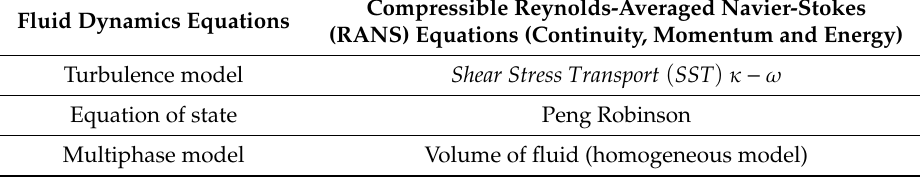
Table 1. A list of the equations and models used for the